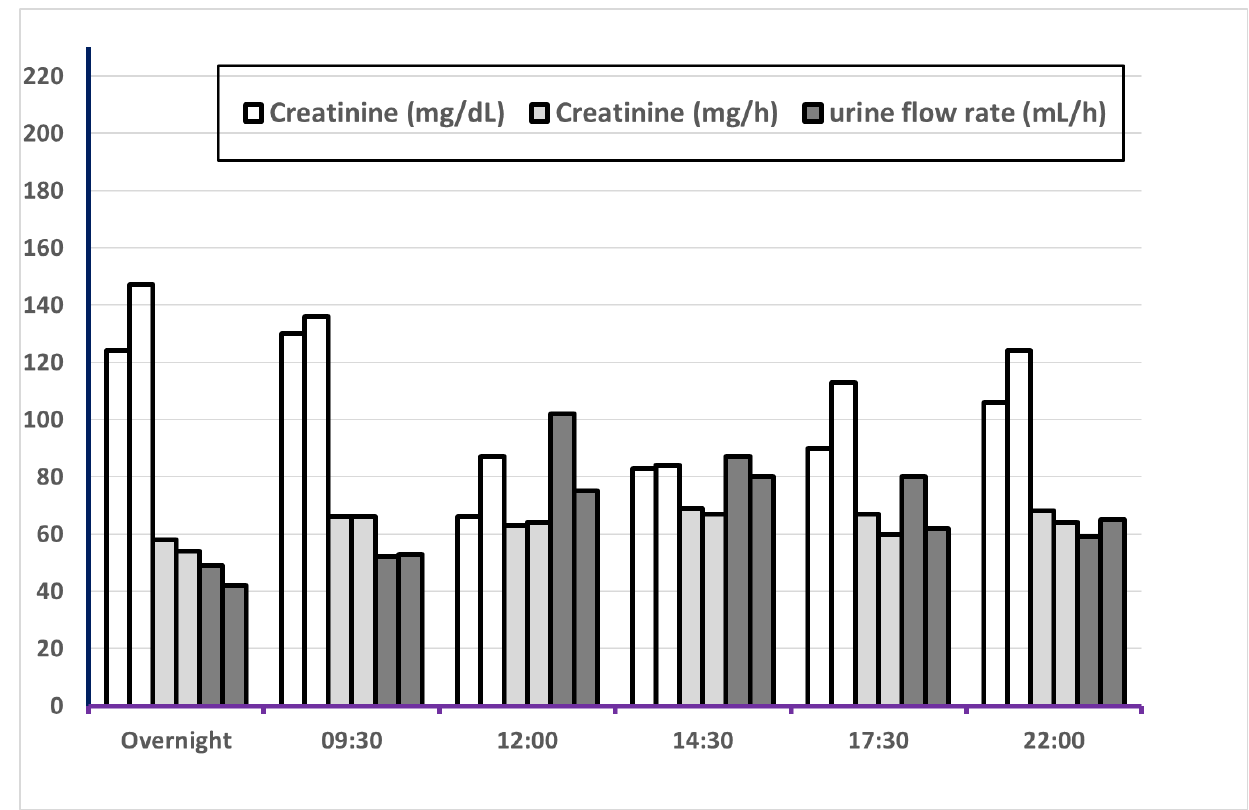
Figure 2. Median values of creatinine concentration, creatinine excretion rate and urine flow rate for 60 subjects on each of two 24 h periods. For each measure, the left bar represents Day 1 and the right bar Day 2.